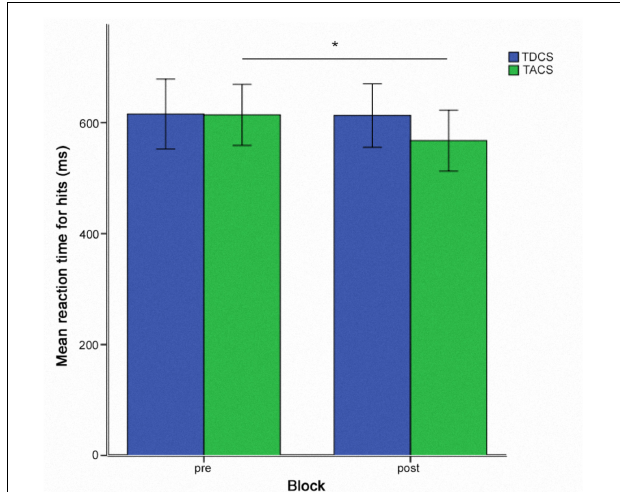
FIGURE 5 | Reaction times for hits for sessions two and three pooled together for TACS and TDCS, in a within-subject crossover design ( N = 10). ∗ = p < 0.05. Error bars represent one standard error of the mean.